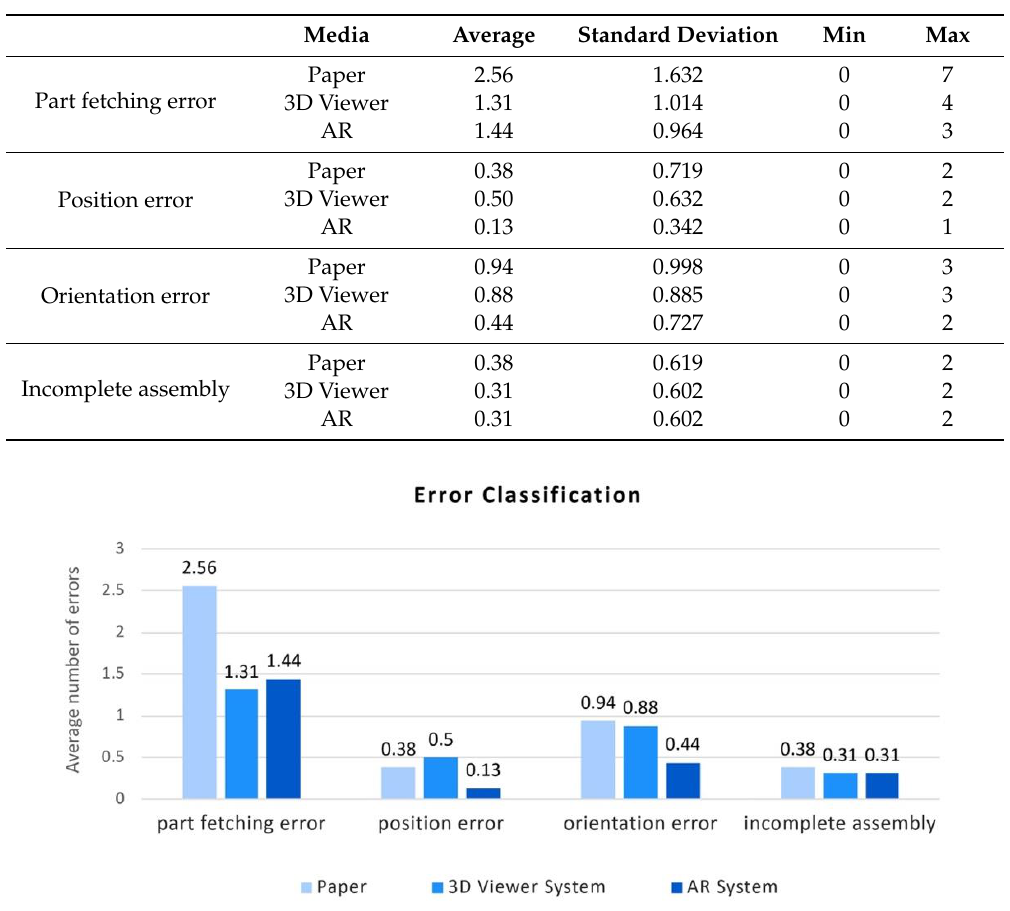
Table 7. Experimental result of various errors (units: # of times).